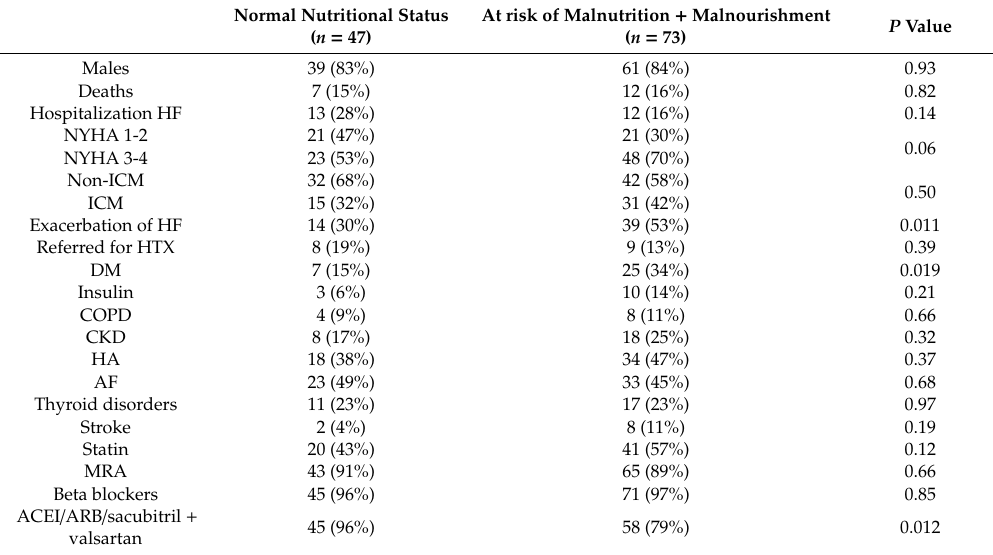
Table 4. Di ff erences between the patients with normal nutritional status and the combined groups of malnourished patients and those at risk of malnutrition. Normal Nutritional Status At risk of Malnutrition + Malnourishment P Value ( n = 47) ( n = 73) Males 39 (83%) 61 (84%) 0.93